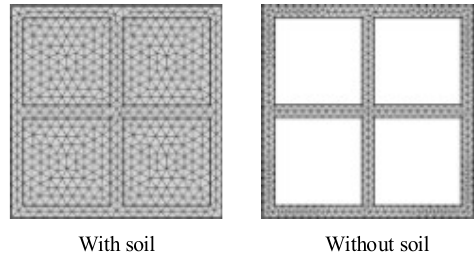
Figure 4. The meshing results of the FEM model.